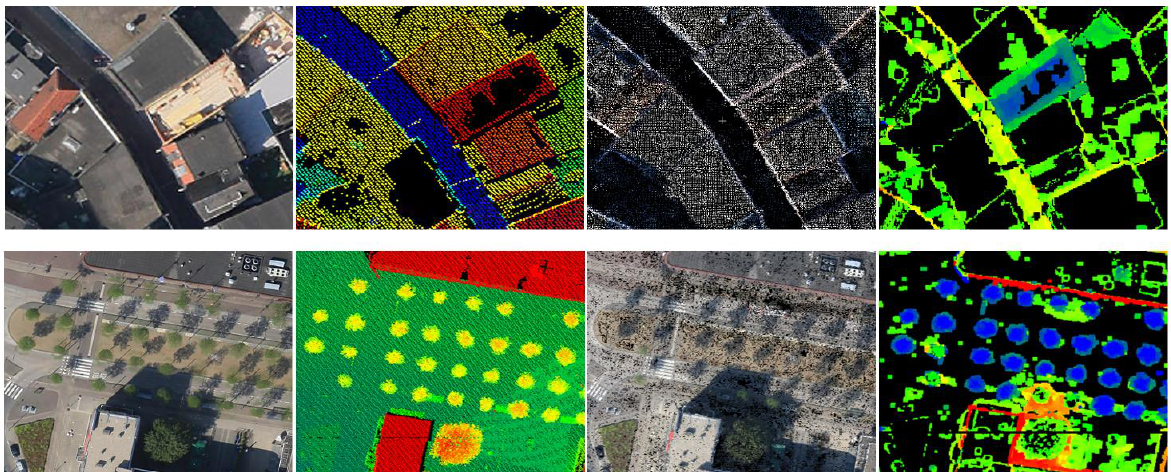
Figure 1. A comparison between laser scanning data and dense matching data. From left to right: orthoimages for reference, laser scanning points colored by height (red colors mean higher points), dense matching points with true colors, DSM differencing colored by height (red colors mean large differences). The top row shows a dense residential area; the bottom row a scene with one tall tree at the middle bottom and thirty short